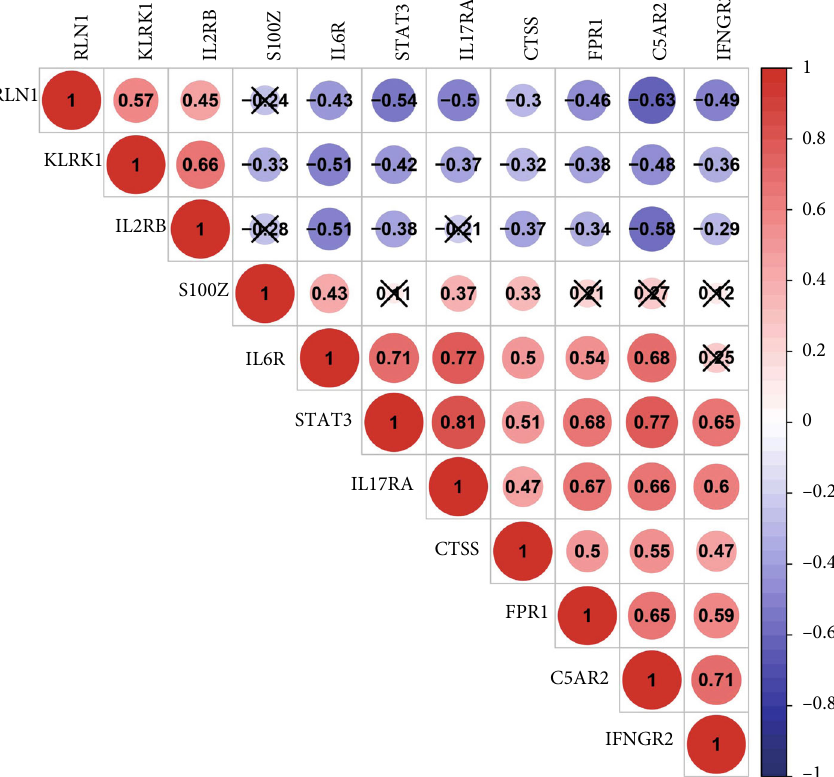
Figure 2: We obtained reciprocal correlations between the 11 candidate IRGs by R package corrplot, with numbers for correlation coe ffi cients, red for positive association, and blue for negative. × : p > 0 : 05